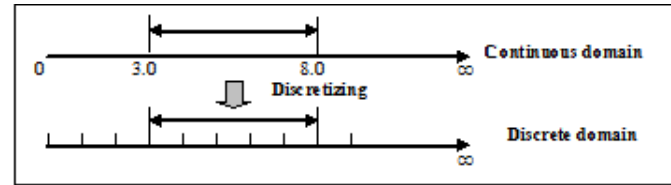
Fig. 1 Discretising the continuous